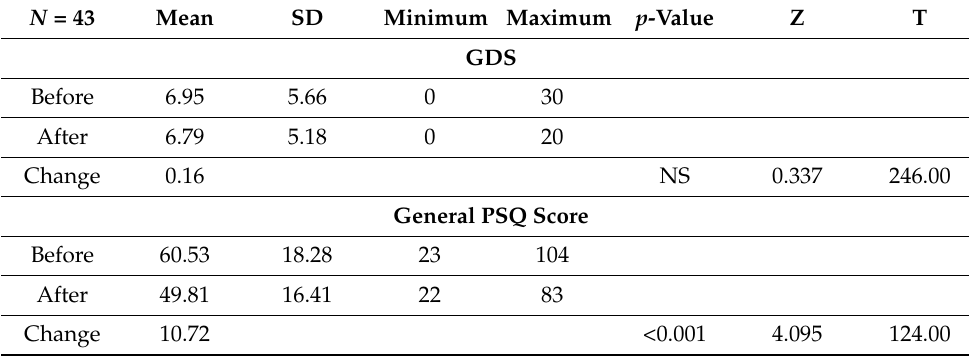
Table 5. Effects of a 3-month intervention on the results of GDS and PSQ scales in the Wilcoxon rank